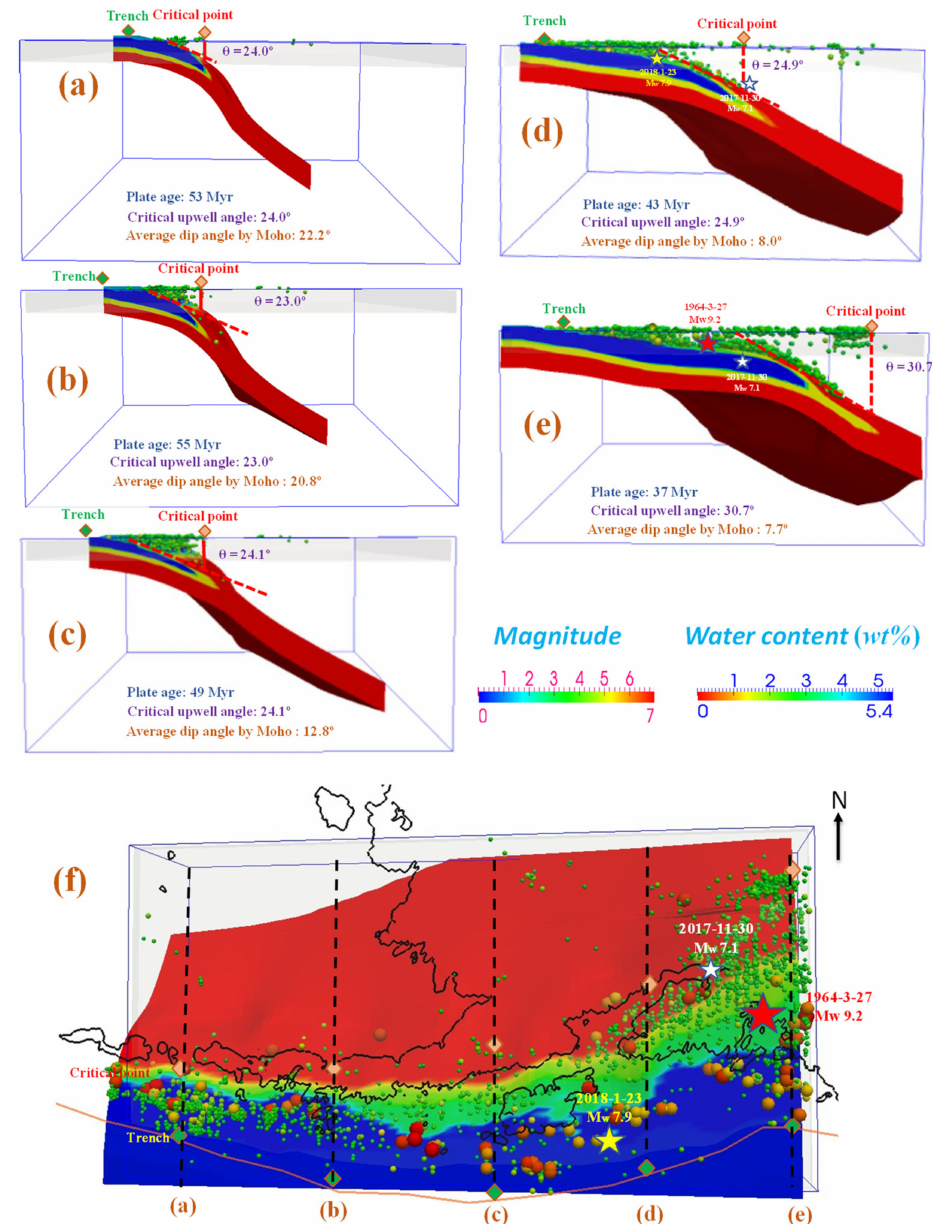
Figure 5. Wedge-earthquake distribution along five profiles ( a – e ) perpendicular to the margin from west to east. Slab color indicates the water content (wt %) distribution, which are the same with Figure 4. ( a – e ) Cross-section of wedge-earthquake distribution along a profile. ( f ) Distribution of profiles ( a – e ). The black dashed lines indicate the a–e profiles. Dimension scale and orientations of profiles are exhibited in ( f